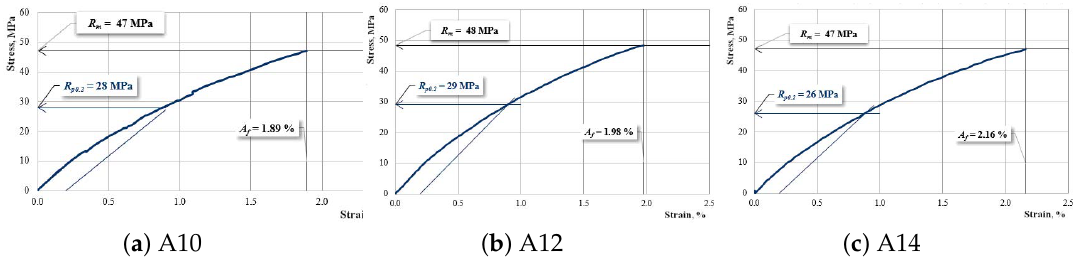
Figure 6. The characteristic curve for a sample: ( a ) A10; ( b ) A12; ( c ) A14.